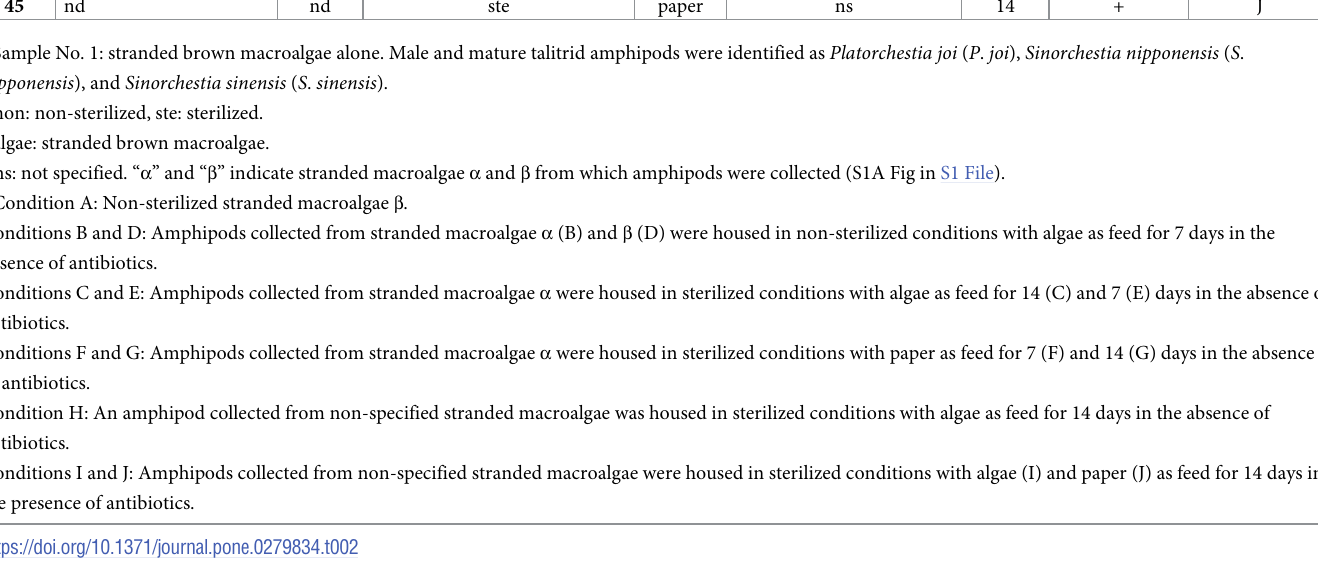
beakers (3 individuals per beaker: 3 beakers without antibiotics, 3 beakers with antibiotics) for the 1st experiment (conducted from May 27, 2021 to July 15, 2021) and 2nd experiment (June 24, 2021 to Aug. 12, 2021). A total of 27 individuals were washed and released (3 individuals per beaker: 9 beakers without antibiotics, 9 beakers with antibiotics) for the 3rd experiment (Oct. 7, 2021 to Nov. 11, 2021).